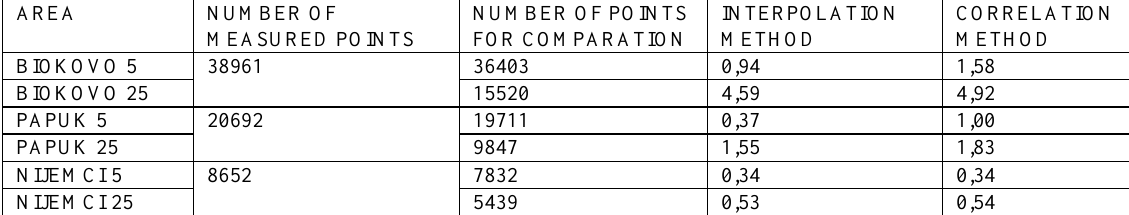
Table 1: Relative accuracy of each model